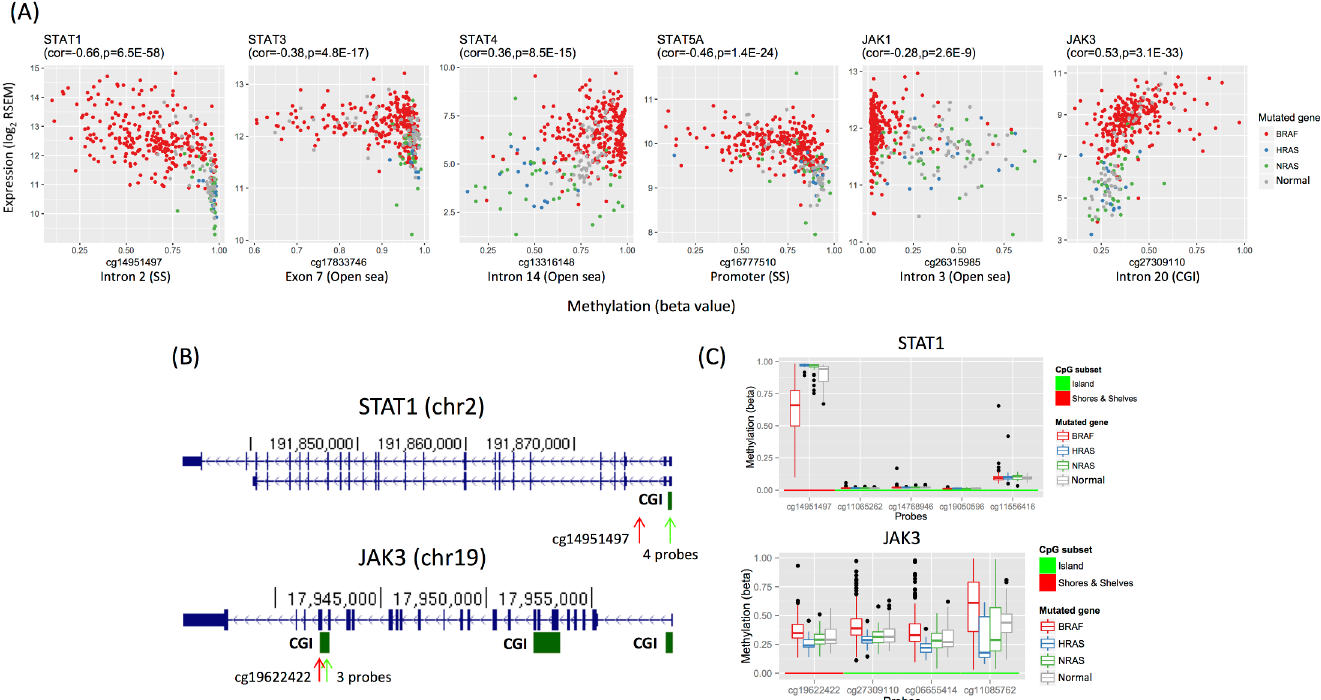
Fig 5. Differential expression of JAK and STAT family genes is correlatedwith differential methylation in thyroid cancer subtypes. (A) Shown are scatter plots for gene expressionlevels (y-axis) and methylationlevels (x-axis) for STAT1 , STAT3 , STAT4 , STAT5A , JAK1 , and JAK3 , plotted with BRAF -mutated ( red ), HRAS -mutated ( blue ), NRAS -mutated ( green ),and normal ( grey ) samples. Gene names and Spearman rho values (with p-values) for the correlationbetweengene expressionand methylationamongtumor samplesare shown on top of the plots. Probe names (wheremethylationlevels were measured) and genomiclocations are shown on the bottom of the plots. (B) Snapshots from the UCSC genomebrowserfor STAT1 and JAK3 , with CpG islands(CGIs) indicatedbelow ( greenarrow : CGIs; red arrow : probes flankingthe CGIs). Methylationlevels of the indicatedregionsare shown in panel (C). (C) Box plots show methylationlevels (y-axis) at probesin STAT1 and JAK3 for BRAF -mutated, HRAS -mutated, NRAS -mutated, and normal samples. The shown probes fall in the north shores and shelves[or SSs, indicatedby red arrows in (B)] of the STAT1 promoter CGI and the 3’ CGI of JAK3 [indicatedby green arrows in